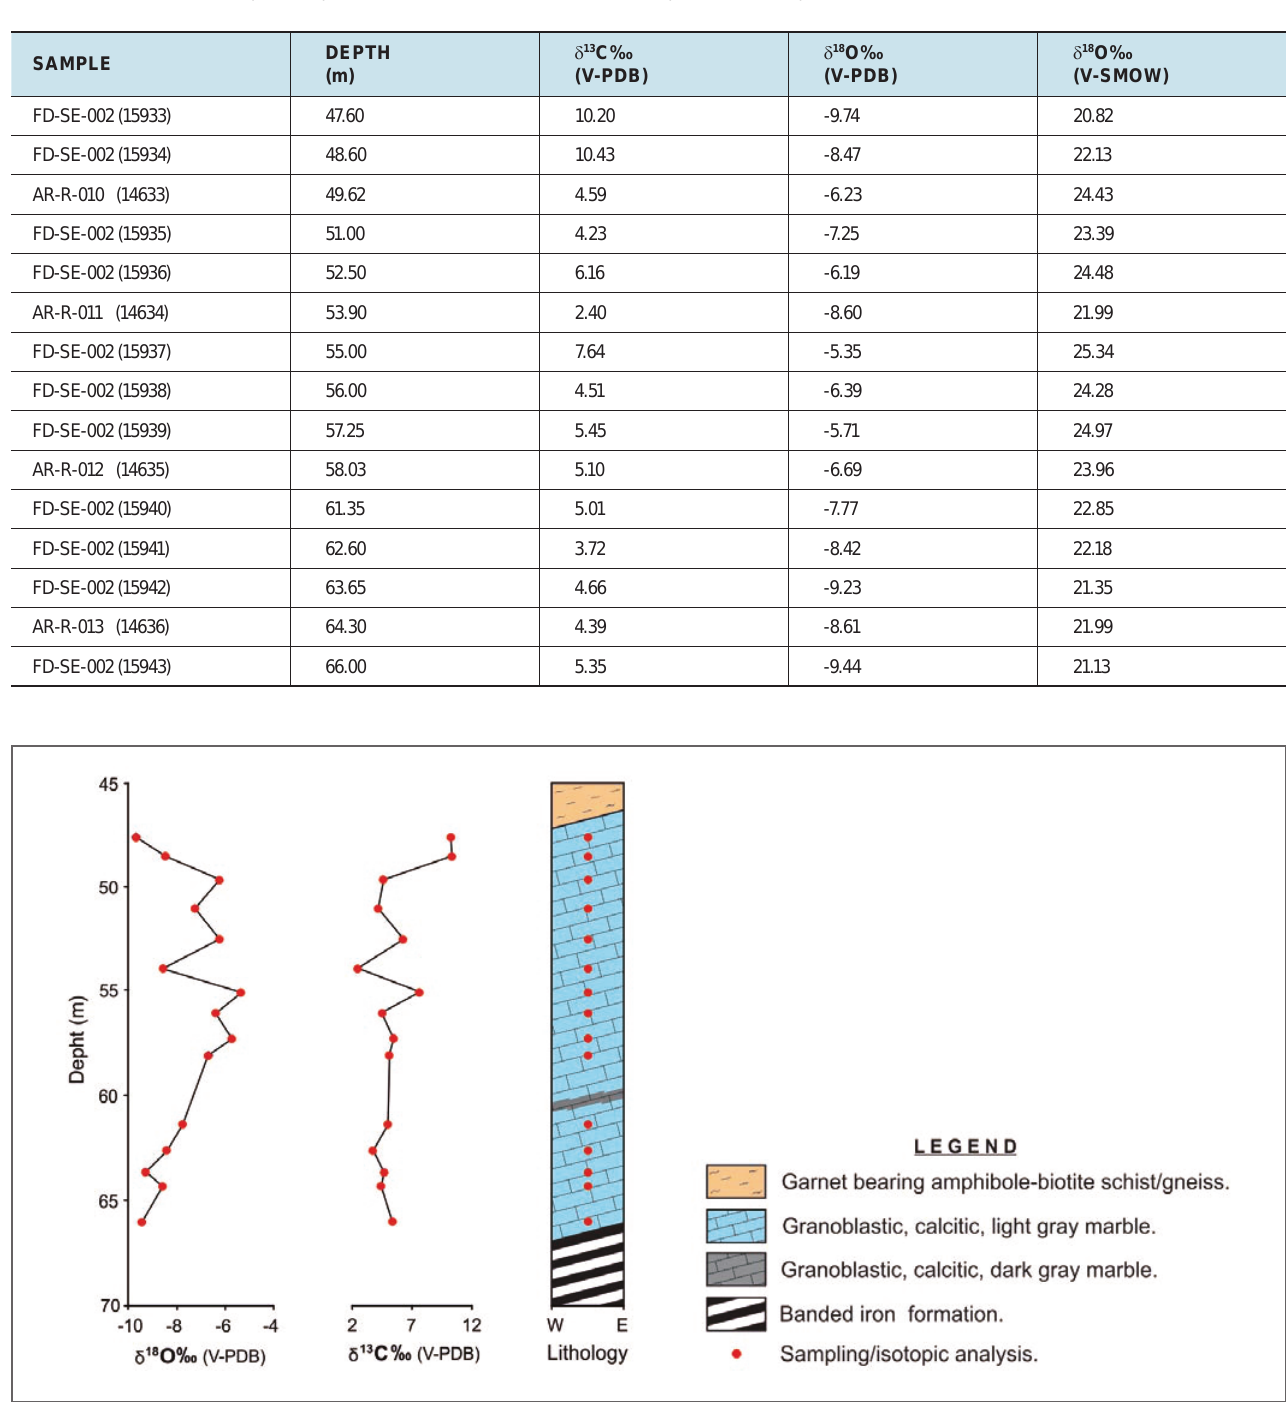
All the analyzed samples correspond to light gray,